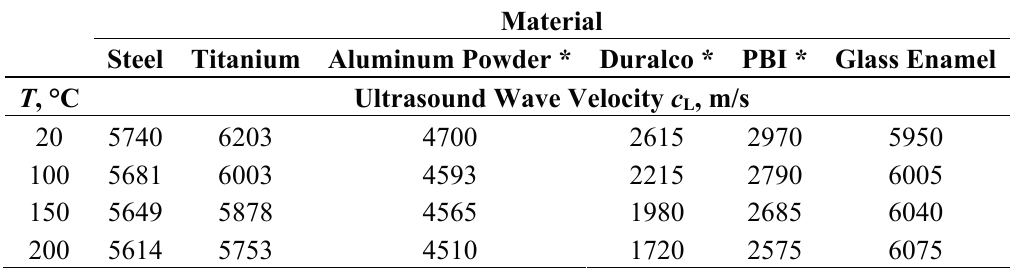
Table 3. Ultrasound longitudinal wave velocities c L for materials at elevated temperatures. Material Steel Titanium Aluminum Powder